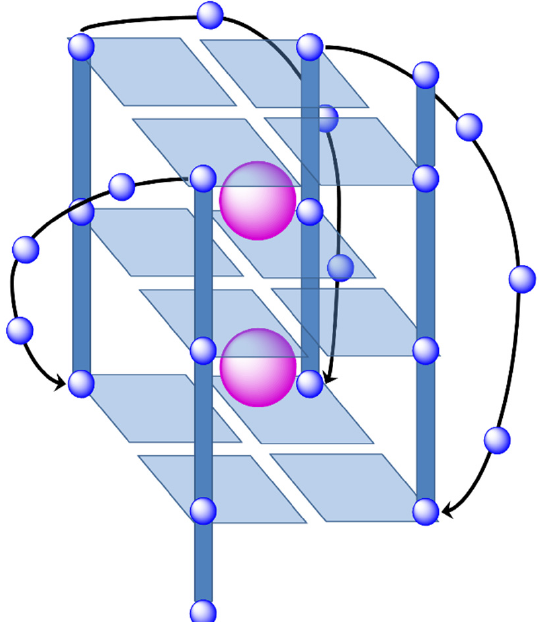
Figure 27. G-quadruplex structure in which three G-tetrads are stacked and stabilized by two alkali